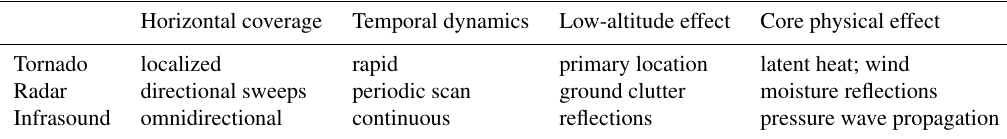
Table 1. Infrasound has several potential advantages over existing weather radar measurements as a potential mechanism for tornado detection and